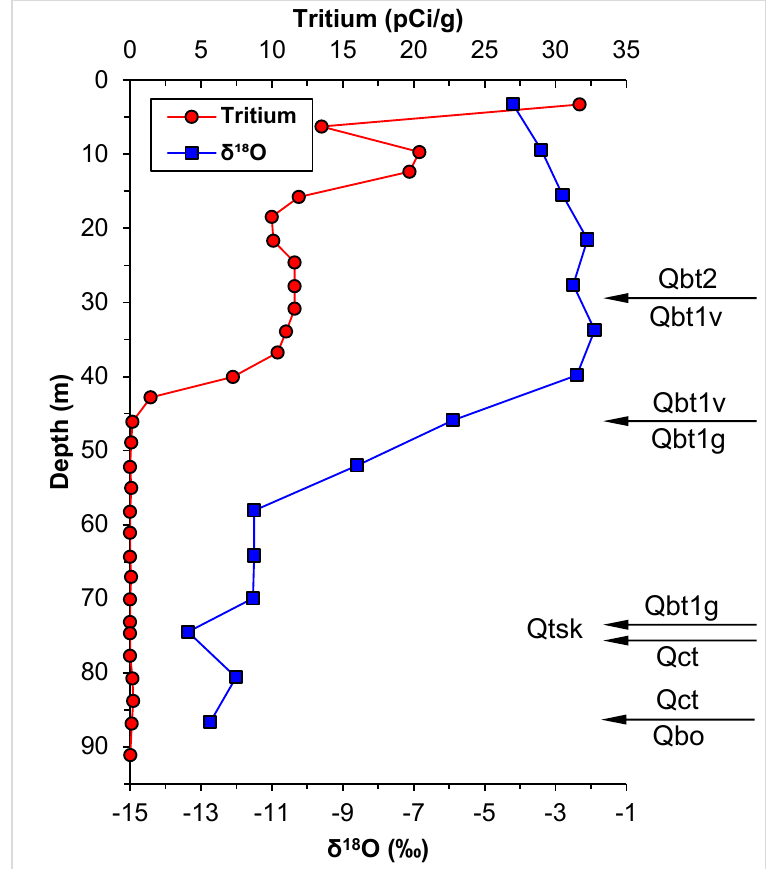
Figure 10. Comparison of δ 18 O and tritium profiles in Borehole 7, TA ‐ 53.